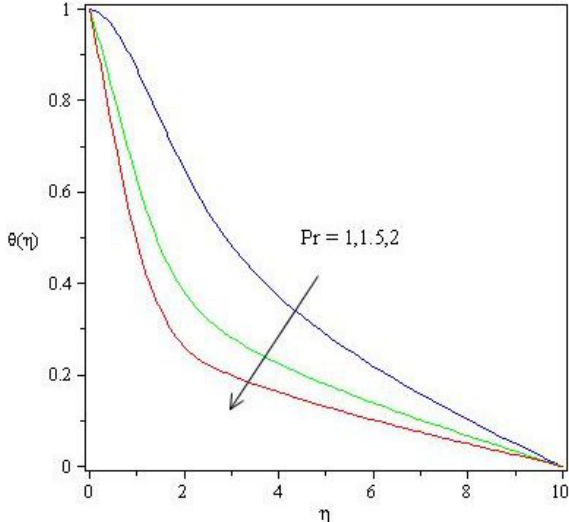
Fig. 17: Temperature profile for different values of Pr and M = 0.5, p = 1, n = 1.5, A = 0.5, B = 0.5